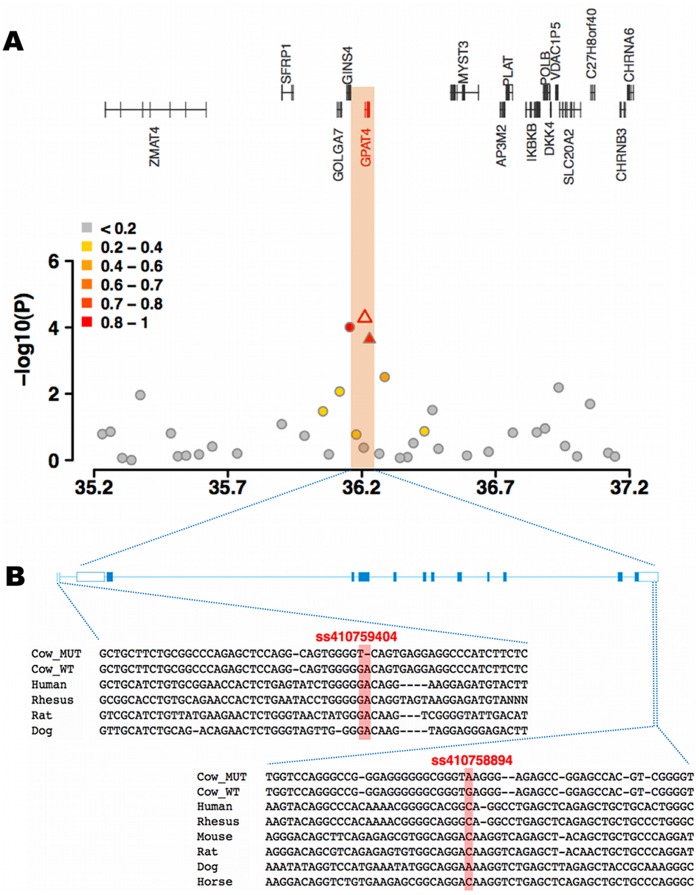
Schematic view of the BTA27 QTL region encompassing GPAT4.(A) The open symbol represents the most significantly associated SNP. Different colors indicate the extent of linkage disequilibrium (r2) between the most significantly associated SNP and all other SNPs. The triangles indicate SNPs resulting from re-sequencing, circles indicate SNPs from genotyping with the 50 K BeadChip. (B) Gene structure of GPAT4 and multispecies sequence alignment of the promoter encompassing the highly significantly associated ss410759404 and of the 3′UTR encompassing the highly significantly associated ss410758894, respectively.